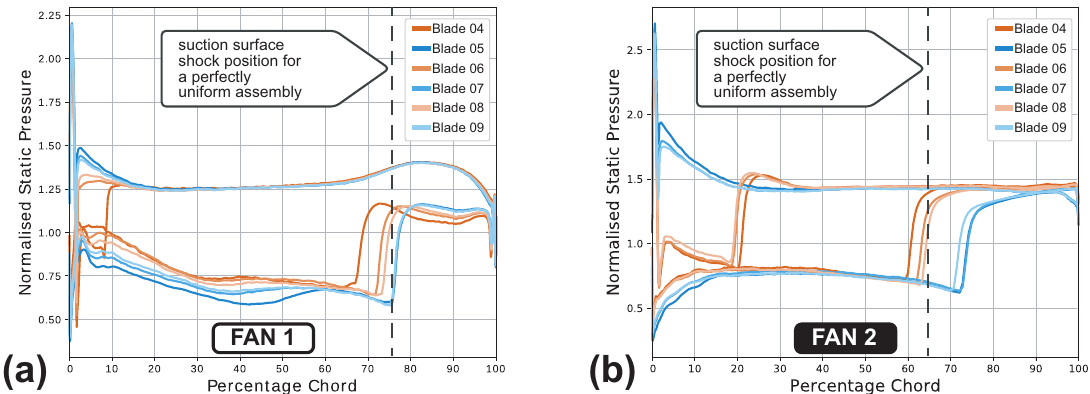
Figure 9. Pressure distribution at blade tips after a full annulus calculation (the worst APD case on the design speed line). ( a ) Pressure distribution changes on Fan 1. ( b ) Pressure distribution changes on Fan 2. Direction of rotation is represented by descending blade numbers. Blade 4 is initially